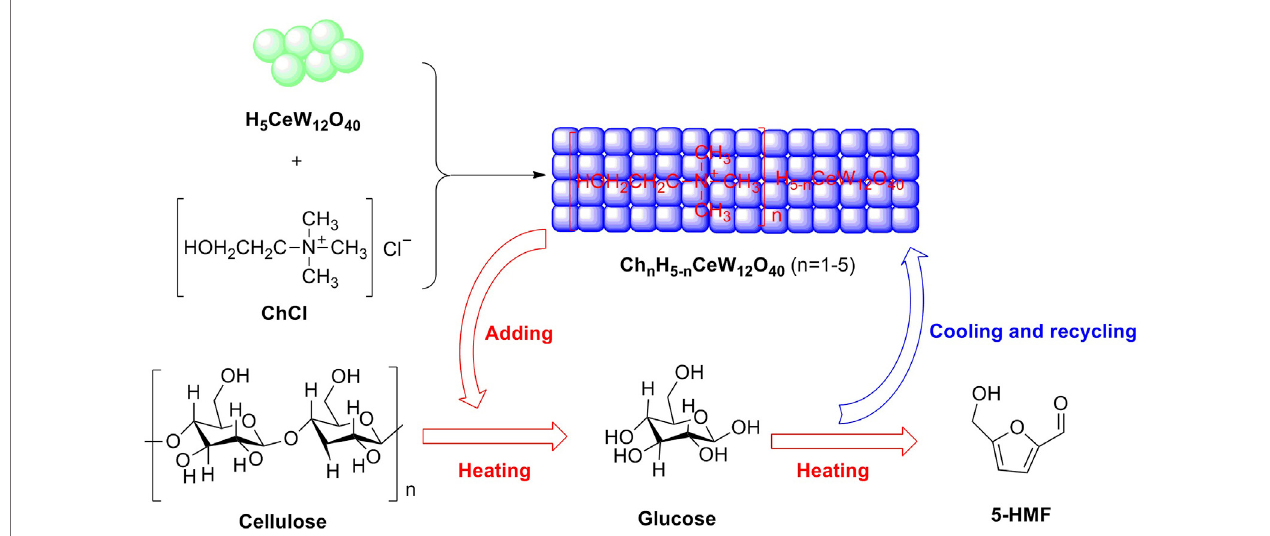
FIGURE 11 | Ce-based HPA of ChH 4 CeW 12 O 40 was synthesized and applied to the selective conversion of cellulose to 5-HMF under heating conditions.